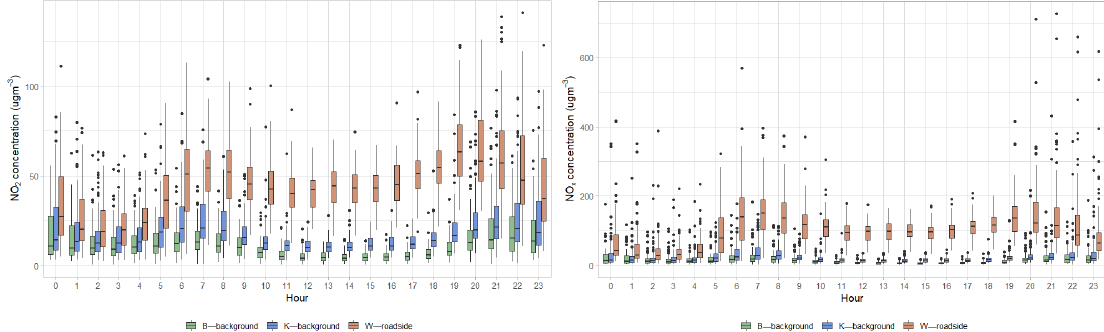
Figure 6. Nitrogen dioxide hourly variability from 10 March to 30 May 2020: NO 2 on the left and NO x on the right side.